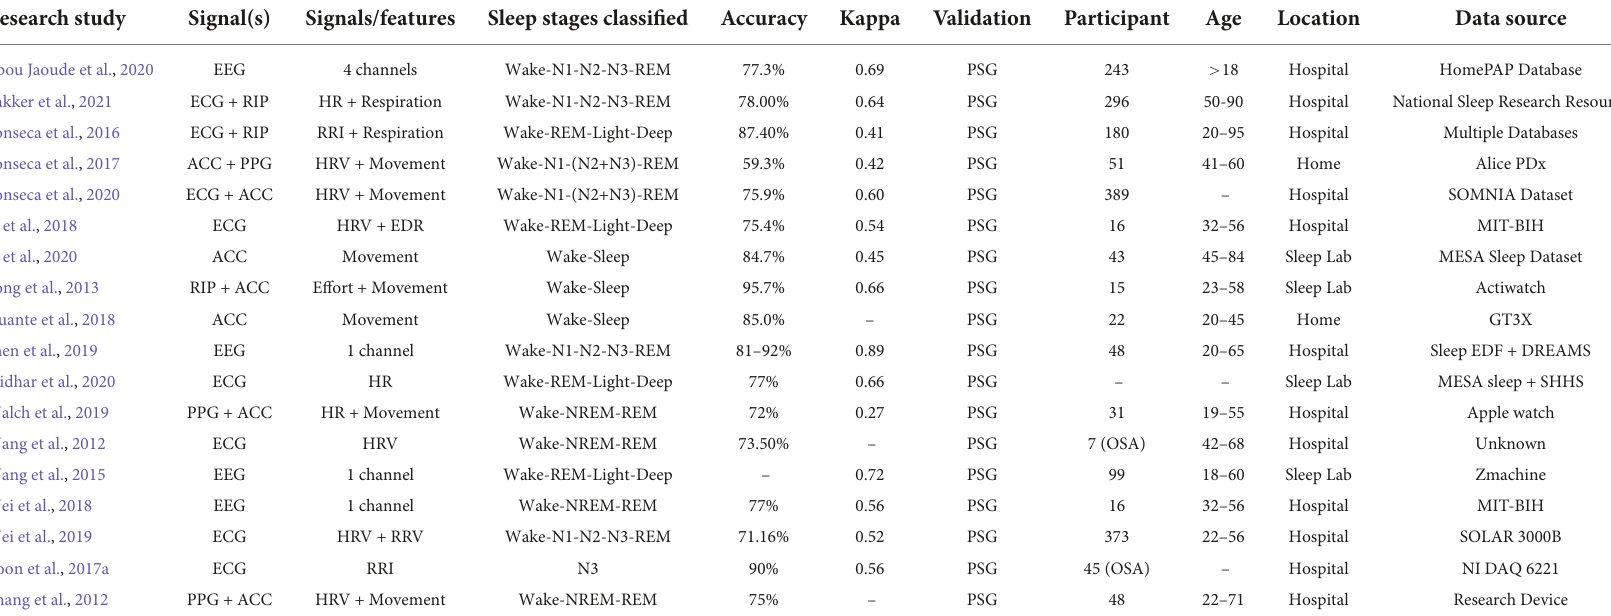
TABLE 5 Summary of articles cited in the discussion section for the purpose of comparing the proposed solution with the existing